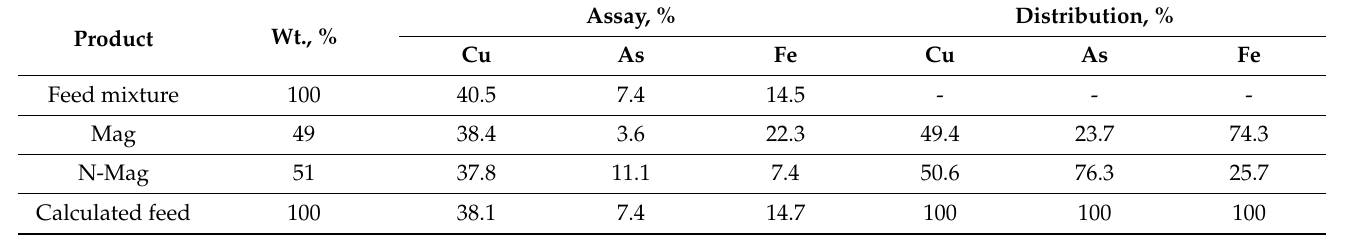
Table 4. XRF assays and distributions of magnetic separation feed and products of chalcopyrite/ tennantite system after microwave treatment.